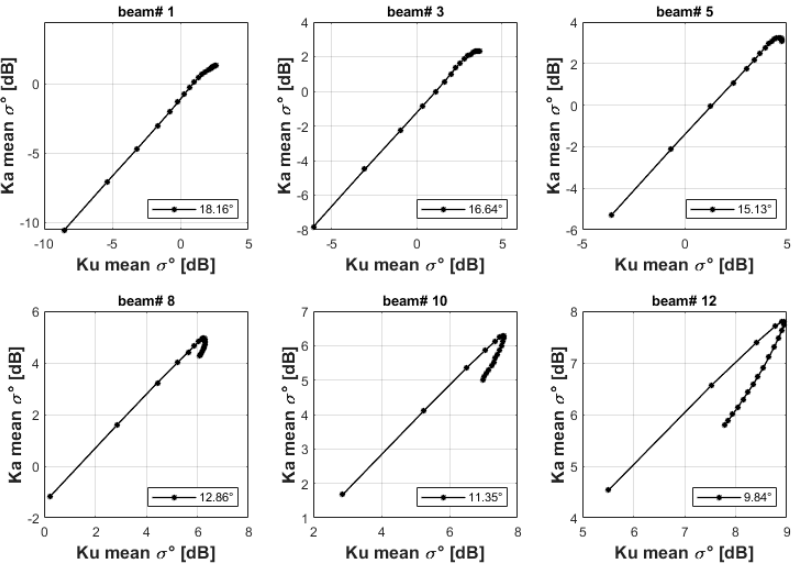
Figure 7. Scatter plot of KaPR mean σ 0 with KuPR mean σ 0 (in dB) for wind speed (WS) = 1–20 ms − 1 at different angular beam positions.